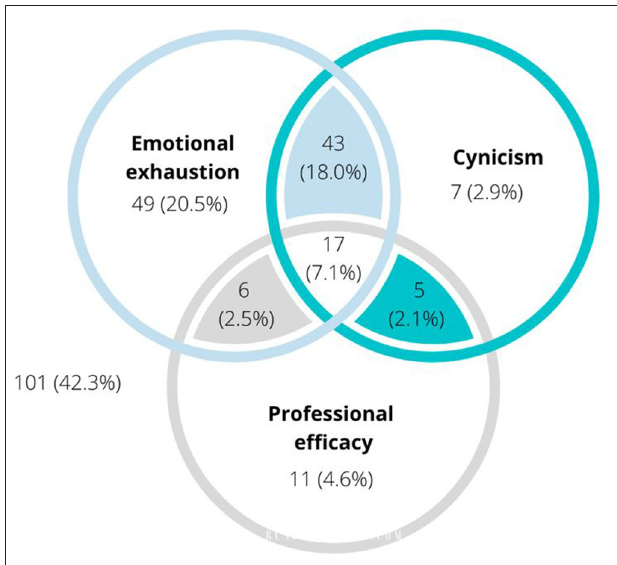
FIGURE 1 | Venn diagram indicating the proportion of MBI respondents ( n = 239) reporting symptoms of burnout (emotional exhaustion, cynicism, and profession efficacy) above thresholds. Where symptoms overlap, this indicates the proportion of respondents exceeding thresholds on both symptoms. Where all three symptoms overlap, this indicates the proportion of respondents exceeding thresholds on all three